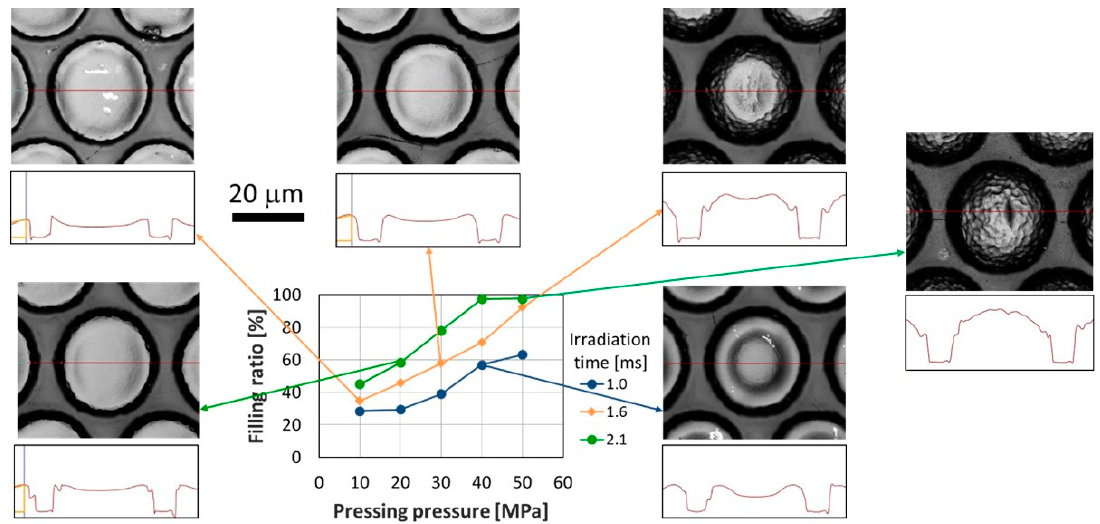
Figure 4. Filling ratio as a function of pressing pressure for each irradiation time in the replication of the 33- µ m-pitch MLA.